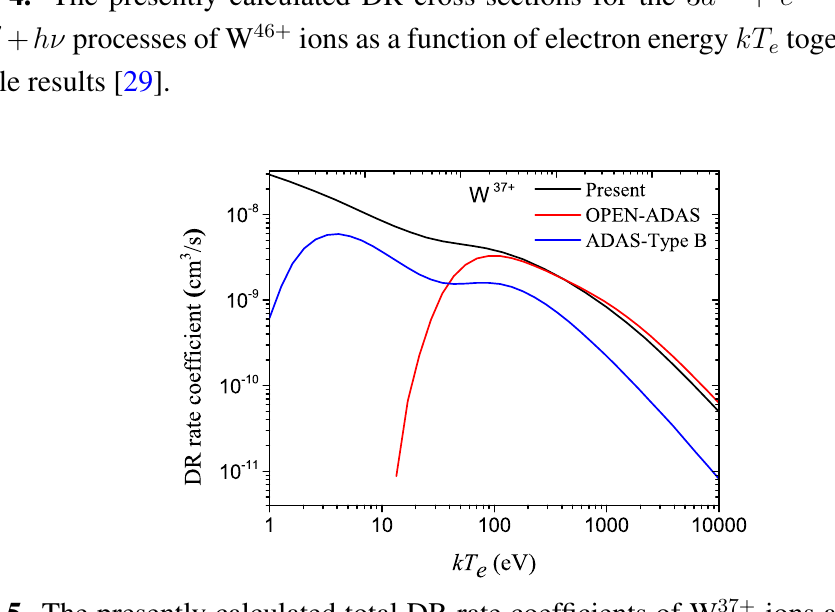
together with other e